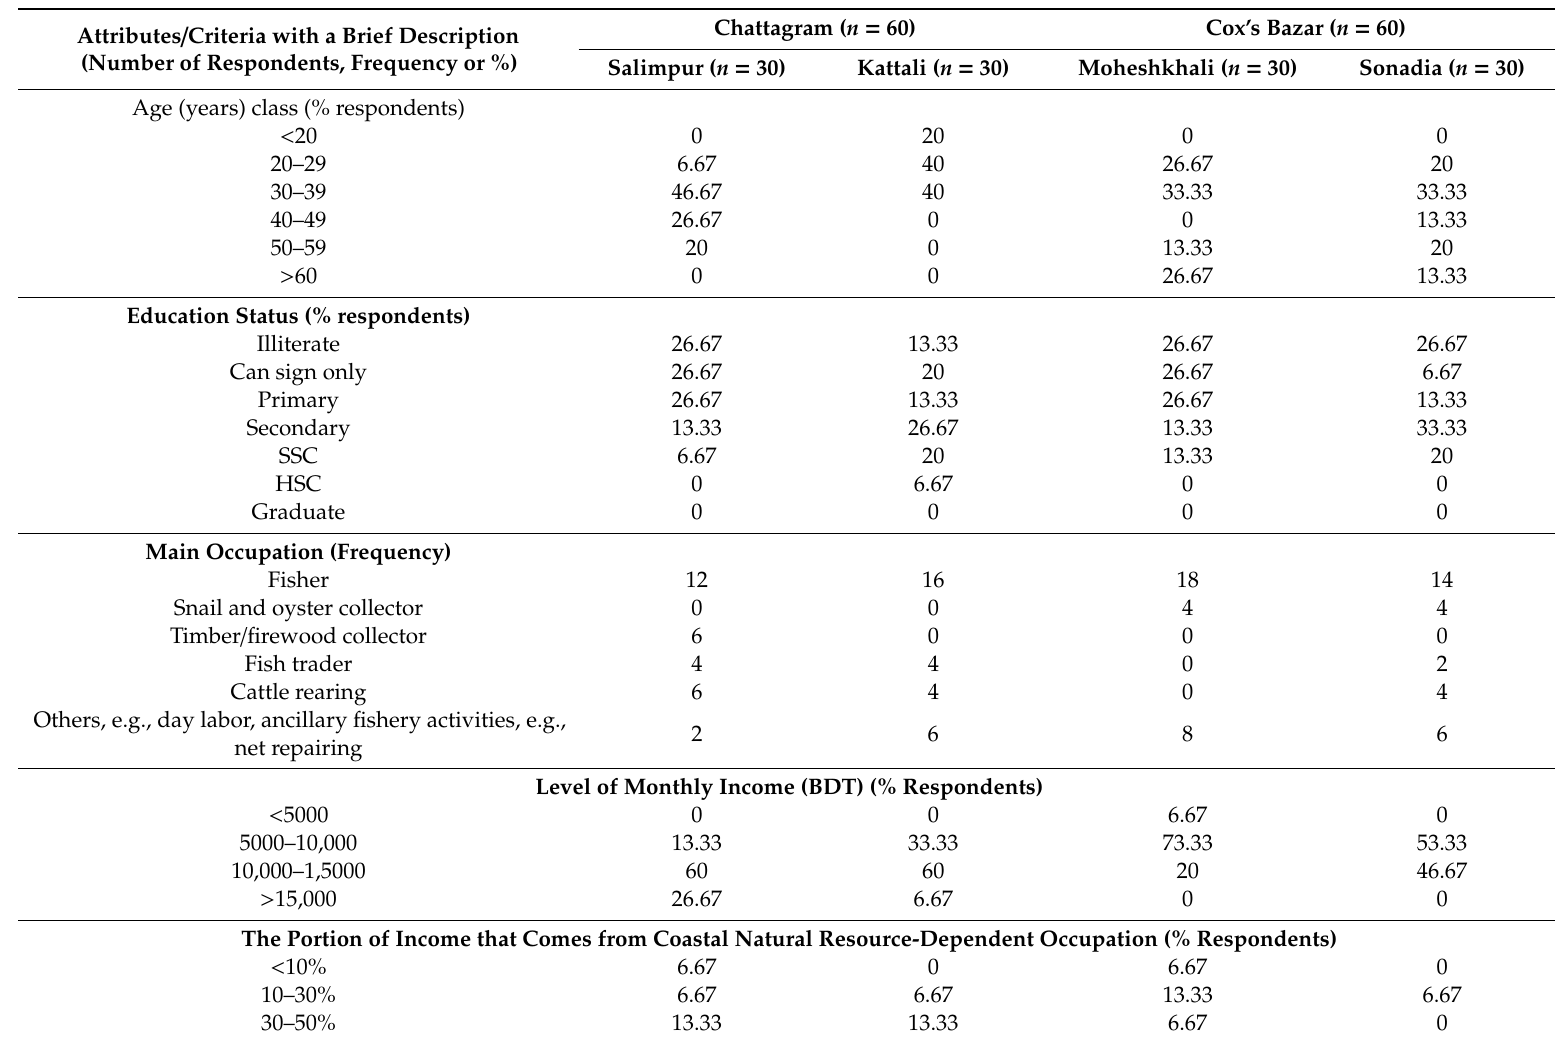
Table A1. Demographic, socioeconomic, and livelihood data on the stakeholders in the study areas of coastal Bangladesh. Attributes / Criteria with a Brief